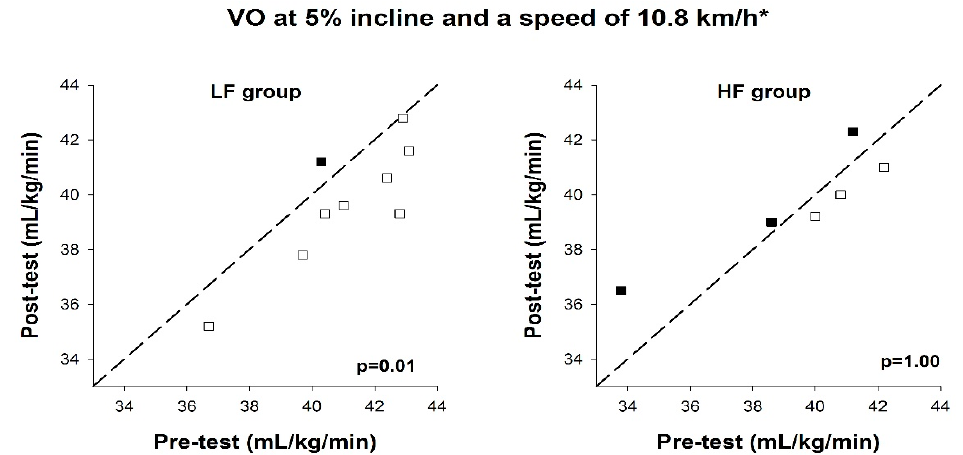
Figure 5. VO 2 at 5% incline and a speed of 10.8 km/h at pre-test and post-test, in the low-frequency group (LF group) and high-frequency group (HF group). Reference lines indicate identical values at pre- and post-test. Each box represents a test subject. Open boxes indicate an improvement and filled boxes indicate a decline, compared to the pre-test. * = 9.0 km/h for women. There was a statistically significant reduction in submaximal HR for the LF group (134 (124–144) vs. 144 (137–152) bpm, p = 0.01) but not for the HF group. Individual results are demonstrated in